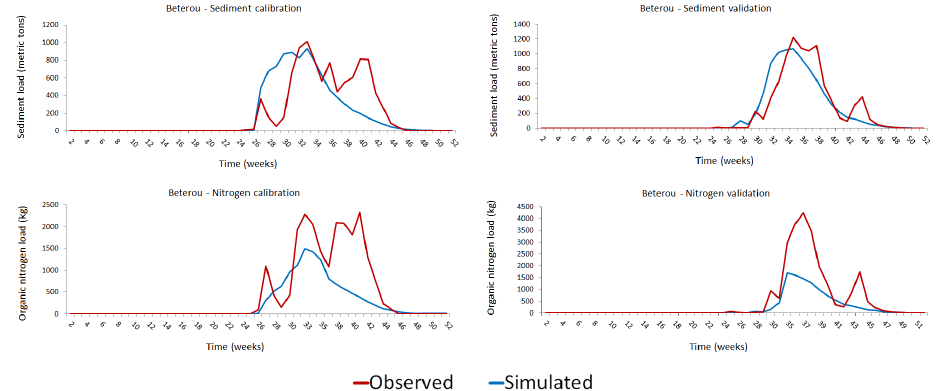
Figure 3. Comparing simulated and observed sediment loads and organic nitrogen loads during calibration and validation at Beterou moni- toring station for the period